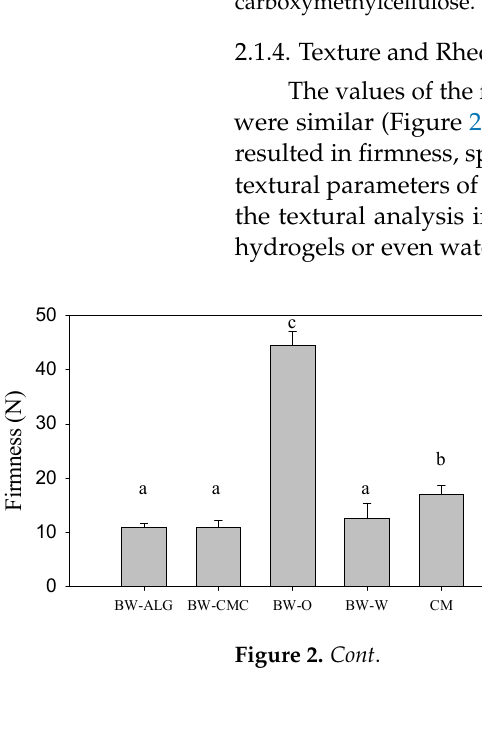
Figure 1. X-ray patterns, confocal images, and structural behavior for ( a ) BW-ALG bigel, ( b ) BW- CMC bigel, ( c ) oleogel, ( d ) hydrogel made from sodium alginate, and ( e ) hydrogel made from carboxymethylcellulose.